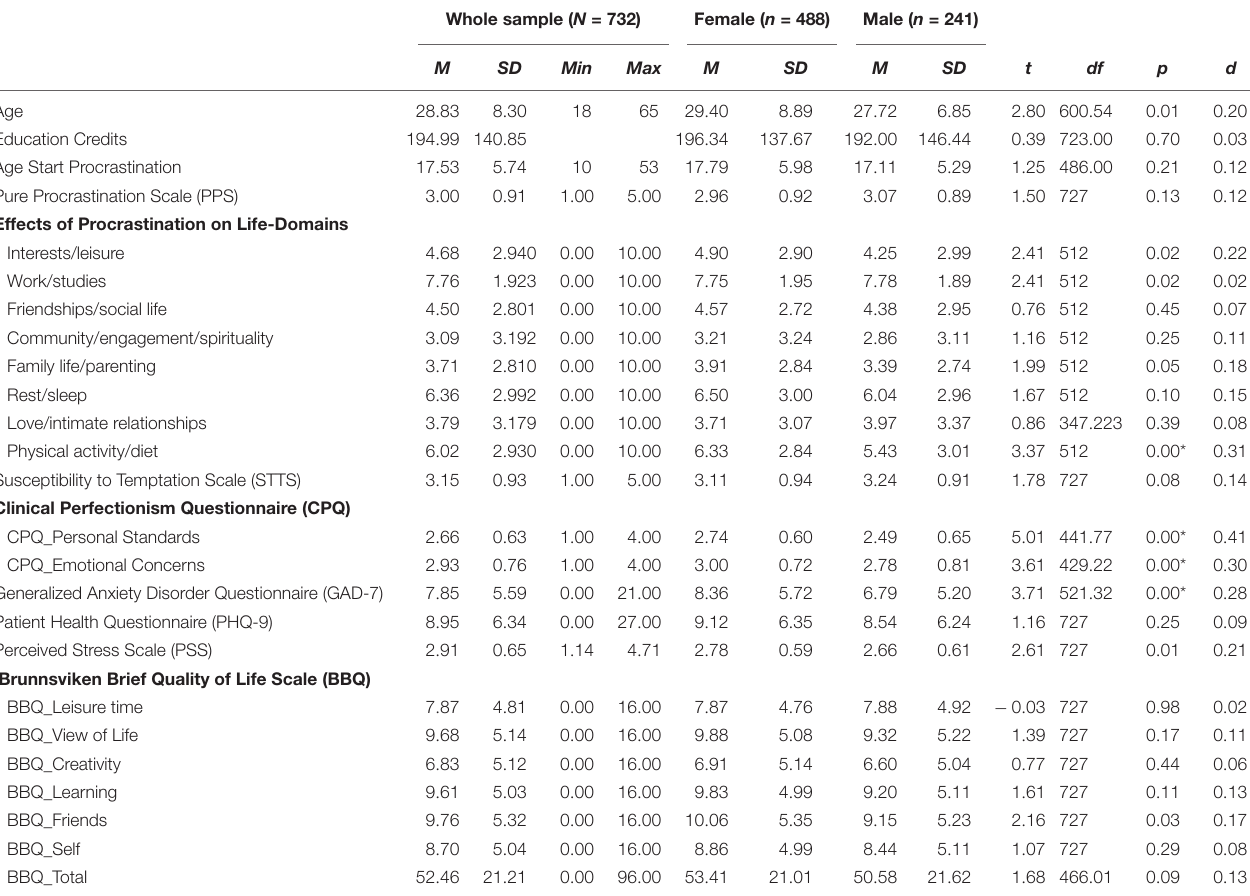
TABLE 1 | Descriptive statistics for whole sample and results of t -tests of gender